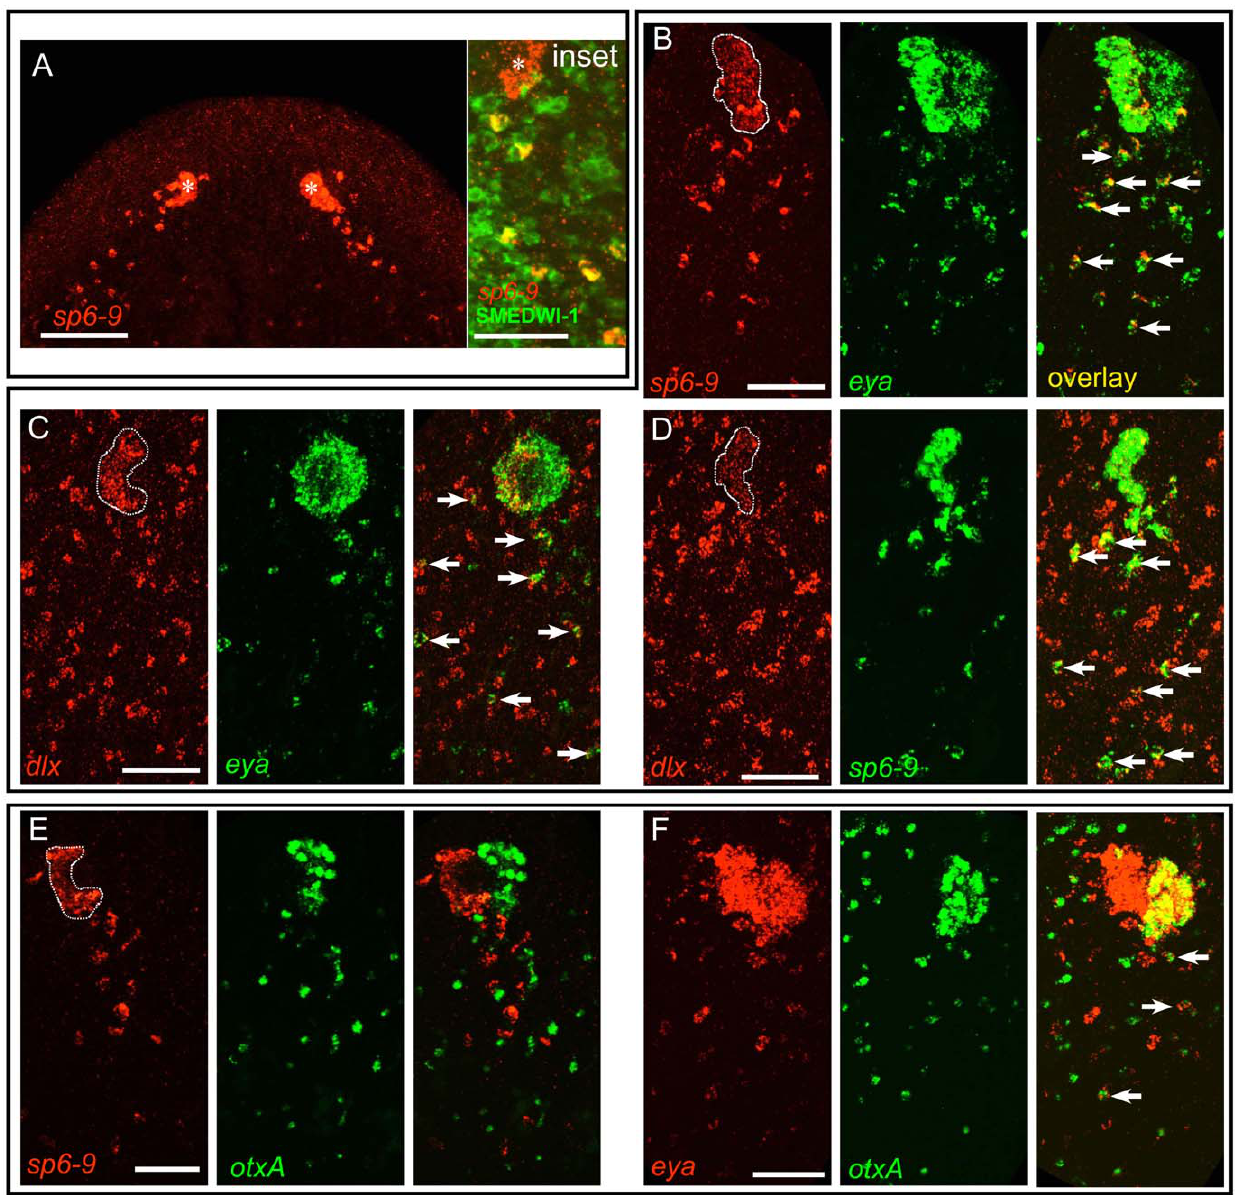
Figure 3. A population of mesenchymal cells posterior to the eye during regeneration expresses optic cup transcription factors. Anterior is up in all images, and all eyes and trails are in blastemas at day 6 of regeneration following decapitation. In all high magnification images of trails only one of two eyes is shown, and images are rotated slightly so that the trail fits into a vertical frame. Fluorescent images are FISH. (A) During regeneration sp6-9 is expressed in the pigment cups (Pcup) and in trails of cells directly behind the pigment cups on the dorsal side of the animal. Inset: sp6-9 + trail cells, but not the eye primordium, are positive for SMEDWI-1 protein. Asterisk indicates eye primordium. (B–D) Double FISH for transcription factors showing that trail cells express combinations of genes also expressed in the cup primordium. sp6-9 -expressing (B) and dlx - expressing (C) cells in the Pcup and trail also express eya . (D) sp6-9 and dlx are co-expressed in the Pcup and in many trail cells. (E) sp6-9 -expressing cells did not express the photoreceptor neuron marker otxA . (F) Numerous eya -expressing cells did express otxA . Arrows show double positive cells. Pigment cup is outlined in (B–E). Scale bars, 100 m m (A), 50 m m in (B–F).